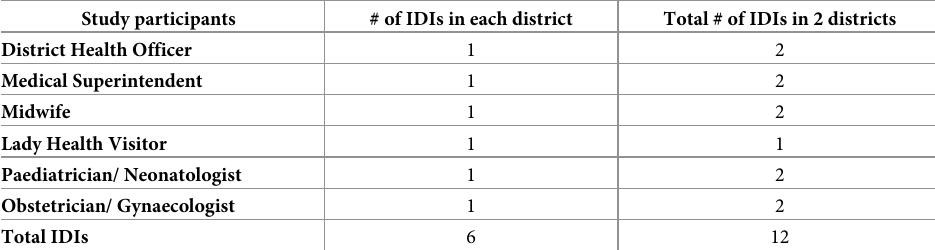
Table 1. Number of in-depth interviews (IDIs)